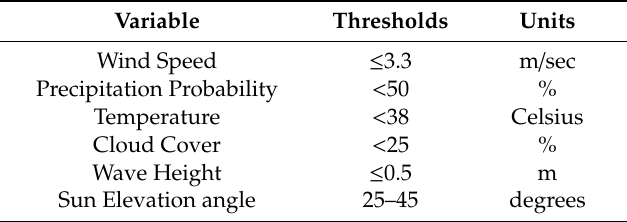
Table 2. Ruleset of the Unmanned Aerial Systems (UAS) toolbox.